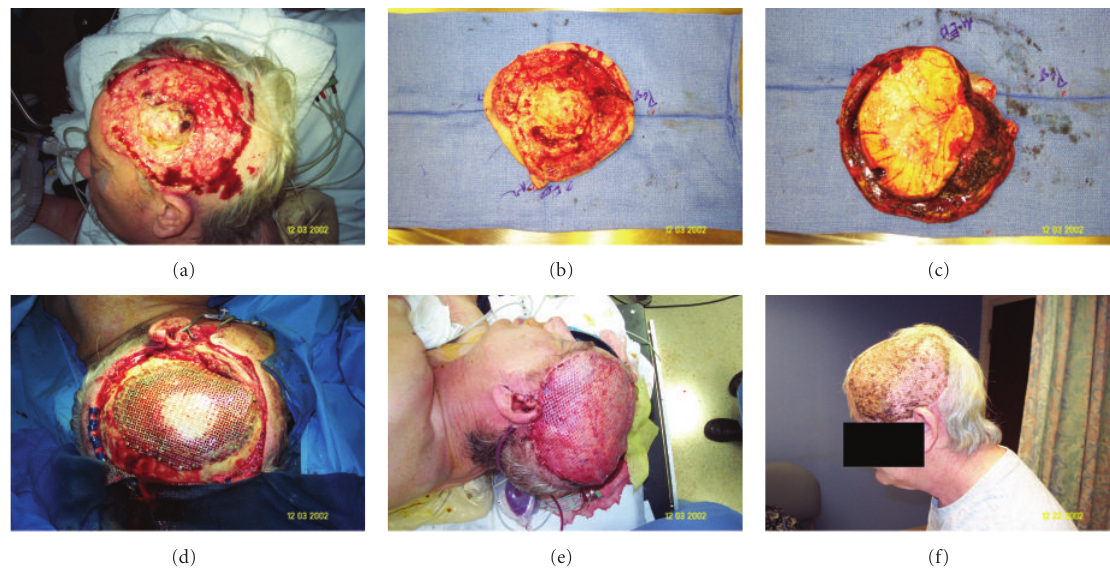
Figure 1: A 65-year-old male with a large, locally advanced left scalp squamous cell carcinoma. (a) Left scalp lesion; (b) excised lesion scalp side; (c) excised lesion cranial side showing parietal cranium; (d) titanium mesh cranioplasty; (e) inset-free latissimus muscle flap with split thickness skin graft; (f) 1-month